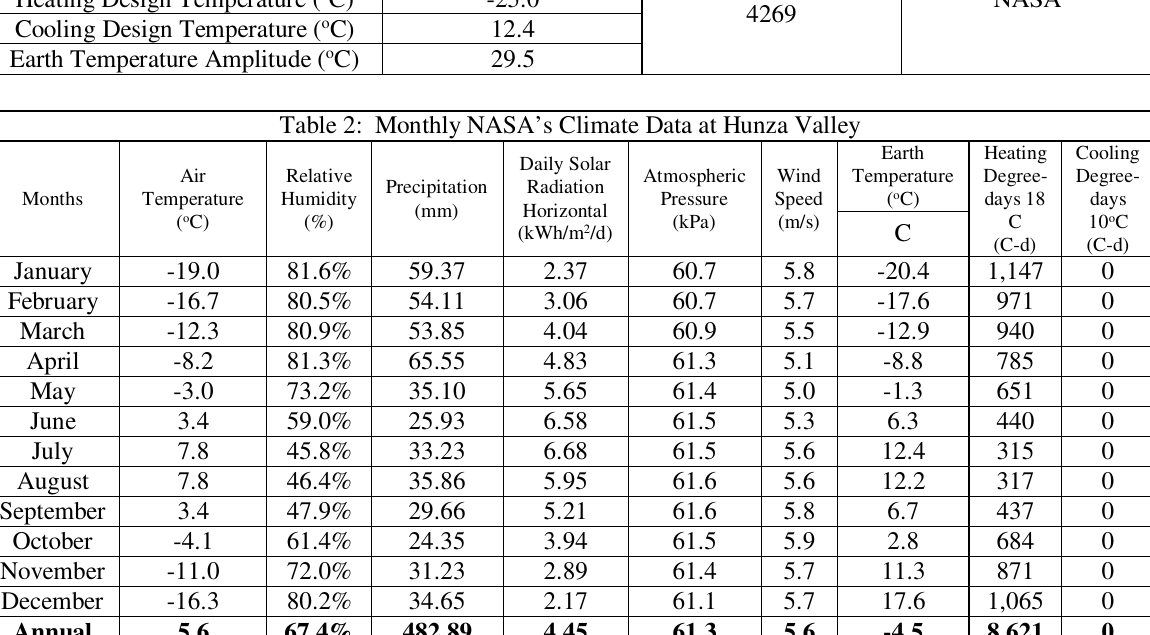
Table 2: Monthly NASA’s Climate Data at Hunza